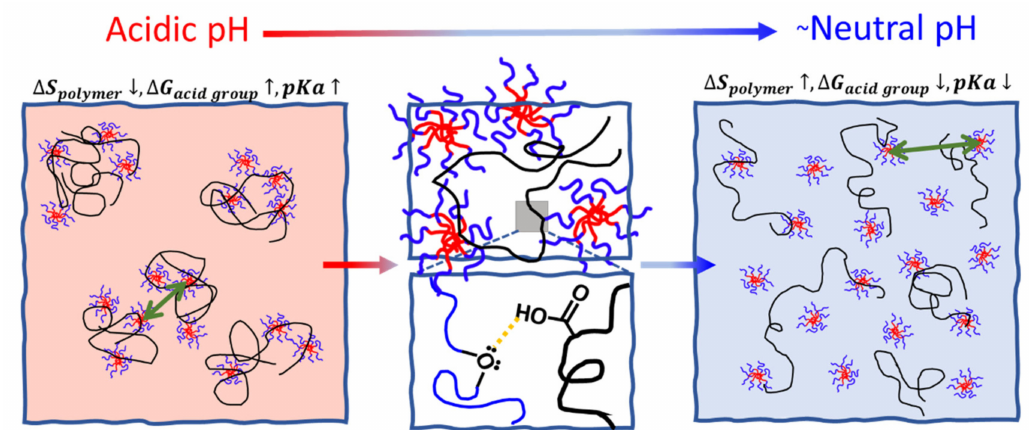
Figure 7. A schematic representation of the suggested combined effect of hydrogen bonding and excluded volume induced by the presence of micelles at low degree of ionization (left). PAA (black line) and core–shell micelles (red and blue). The inset shows specific interactions at two scales. At neutral pH, the PAA chains do not affect the spatial organization of the micelles